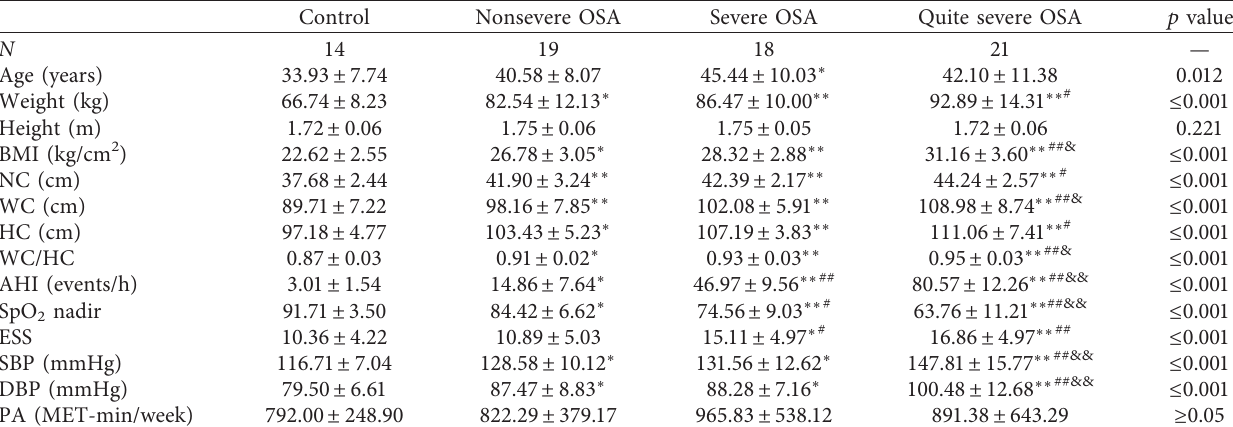
Table 1: Demographic characteristics of the subjects in this study.